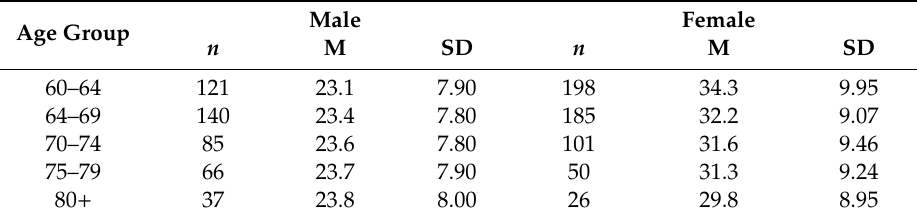
Table 6. Percent body fat based on age group and gender, Unit: %.